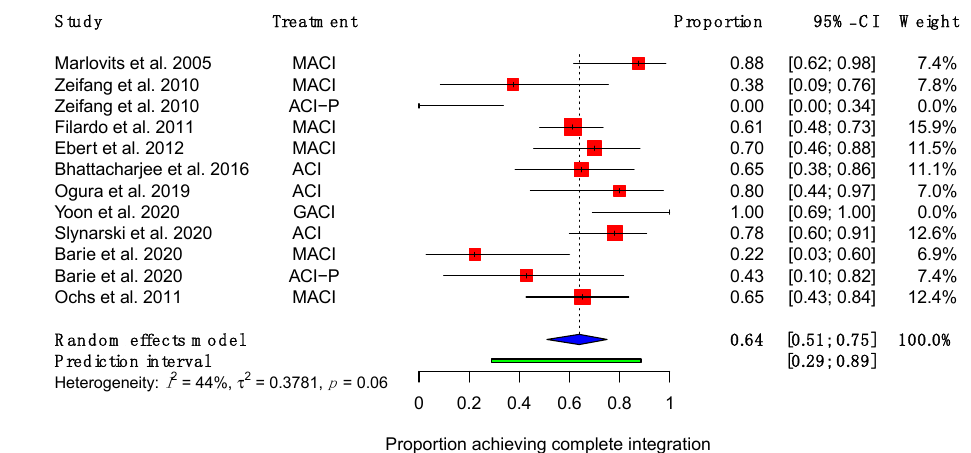
Figure 2. Forest plot on the proportion of patients achieving complete integration after receiving ACI therapy. (Abbreviations: MACI, Matrix-induced autologous chondrocyte implantation; ACI-P, ACI with periosteal flap cover; GACI, gel-type ACI; CI, Confidence Intervals).